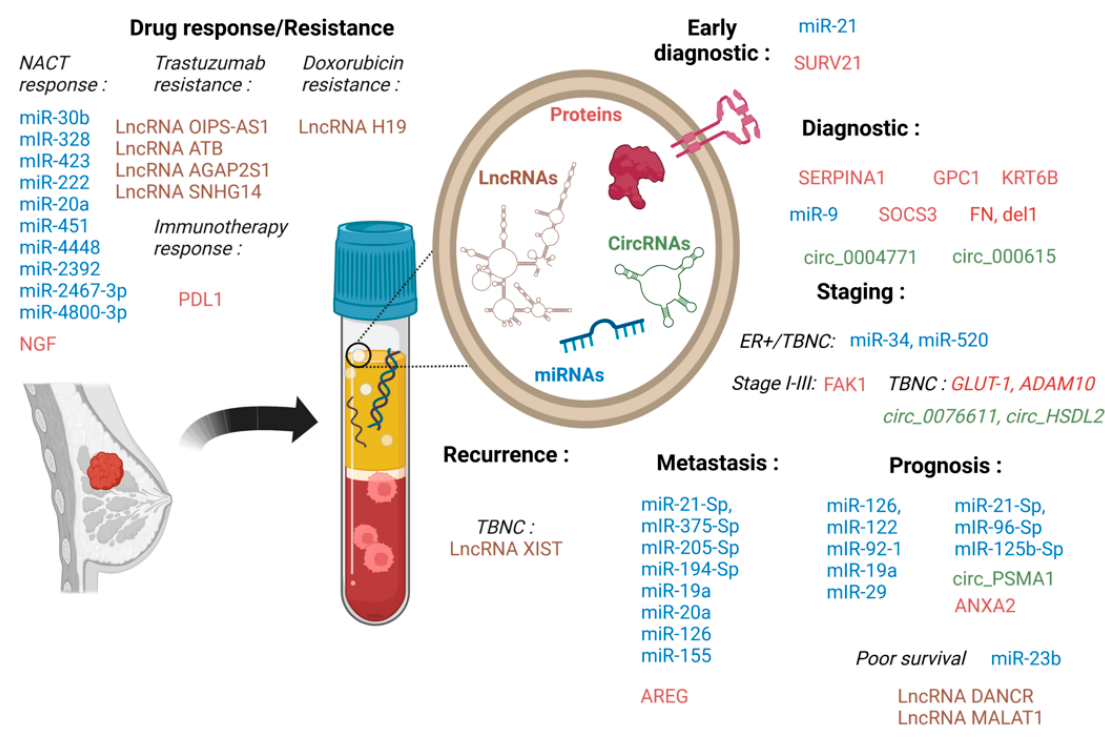
Figure 4. SEVs cargo as relevant breast cancer biomarkers. Among all the molecules present in SEVs, only a subset (proteins, miRNAs, and LncRNAs) have been shown to be of potential clinical value in CRC detection, diagnosis, prognosis, and treatment response evaluation. All referenced markers were found to be differentially expressed in cancer patients and in healthy people: miRs are depicted in blue, LncRNAs in brown, CirRNAs in green, and proteins in pink. NACT: neoadjuvant chemotherapy.This figure was created with BioRender (DT2576K3SR agreement number).